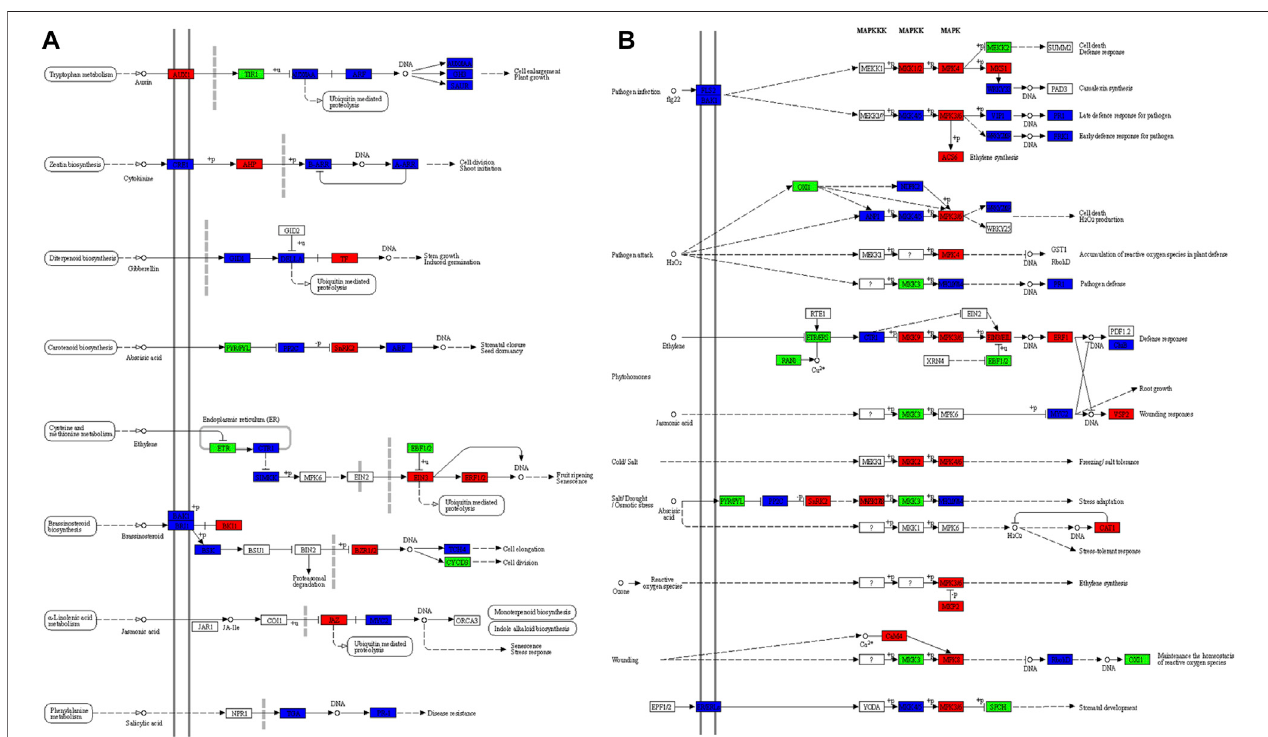
FIGURE 5 | Differently enriched KEGG pathways in C. roseus cells (CMCs vs. DDCs). (A) Plant hormone signal transduction and (B) MAPK signaling-plant pathway. The genes (enzymes) marked in red, green, and blue represent higher, lower, and variable (some transcripts have high and the others have low) expression in DDCs as compared to CMCs, respectively. KEGG maps were developed by using KEGG mapper tool (Kanehisa and Sato, 2020).